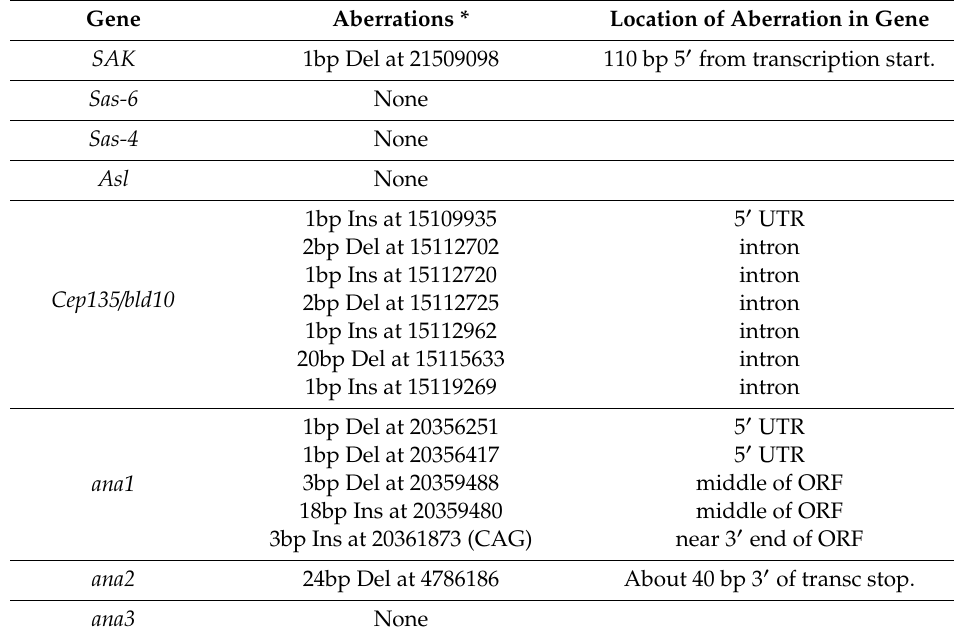
Table 1. Genetic dispositions of centriole biogenesis genes in the 1182-4 cell line. Gene Aberrations